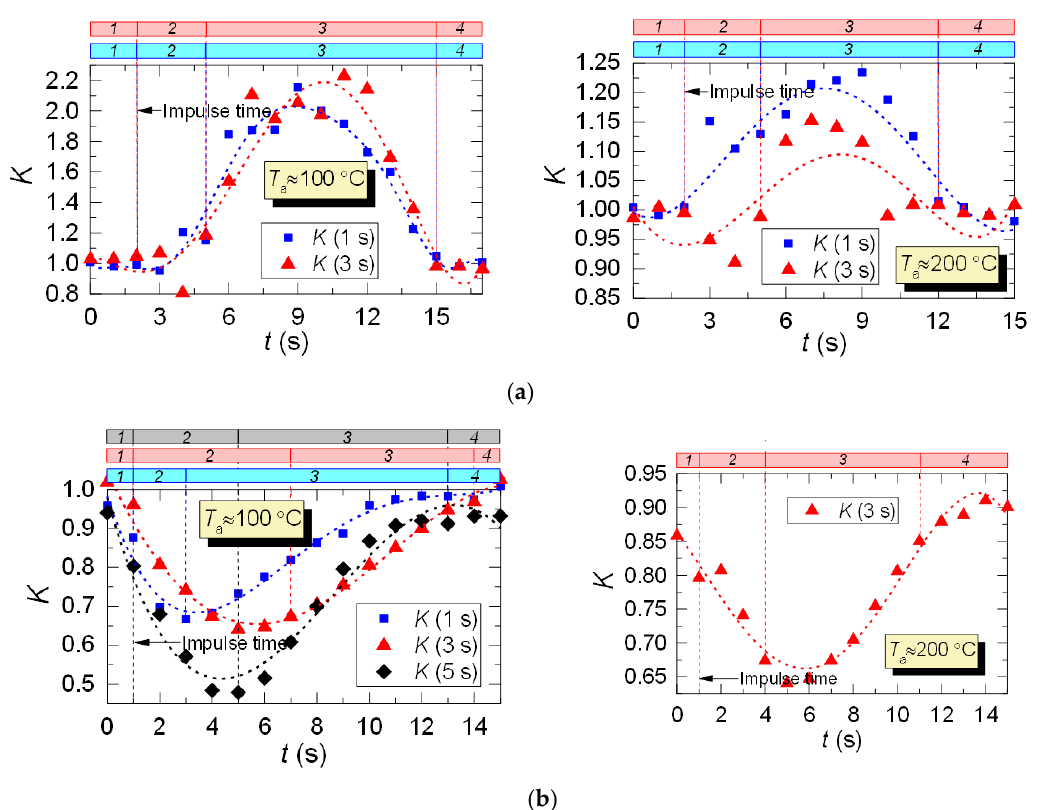
Figure 10. Variation of the adjusting coefficient K in the trace of a droplet flow ( 1 : prior to droplet injection; 2 : T a temperature drop to the lowest value; 3 : T a temperature growth; 4 : T a temperature recovery): ( a ) heated air flow; ( b ) kerosene combustion products flow.